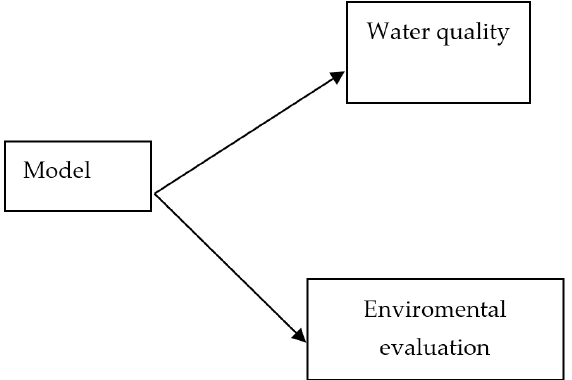
Figure 3. Energy, exergy and economic block diagram.